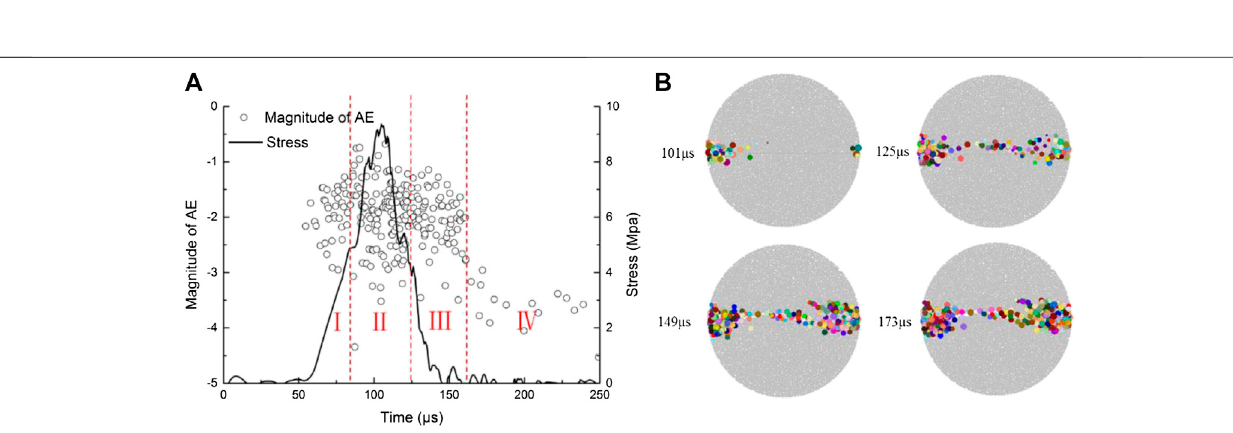
FIGURE 14 | The cumulative counts of different types of micro-crack. (A) is the cumulative counts of different crack types obtained by PFC. (B) is the cumulative counts of AE events and three kinds of AE source mechanism in the simulation.